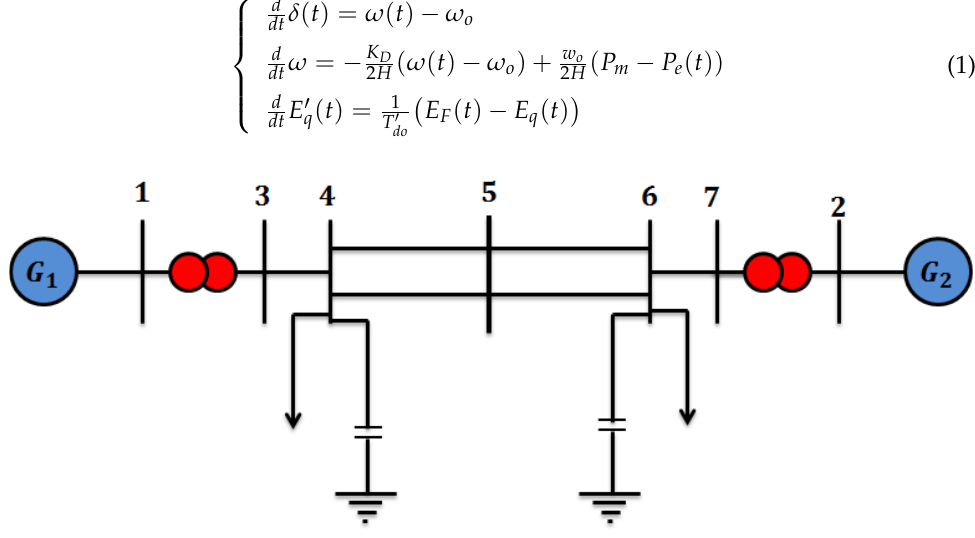
Figure 1. Single-line diagram of a two-zone multi-machine power system.